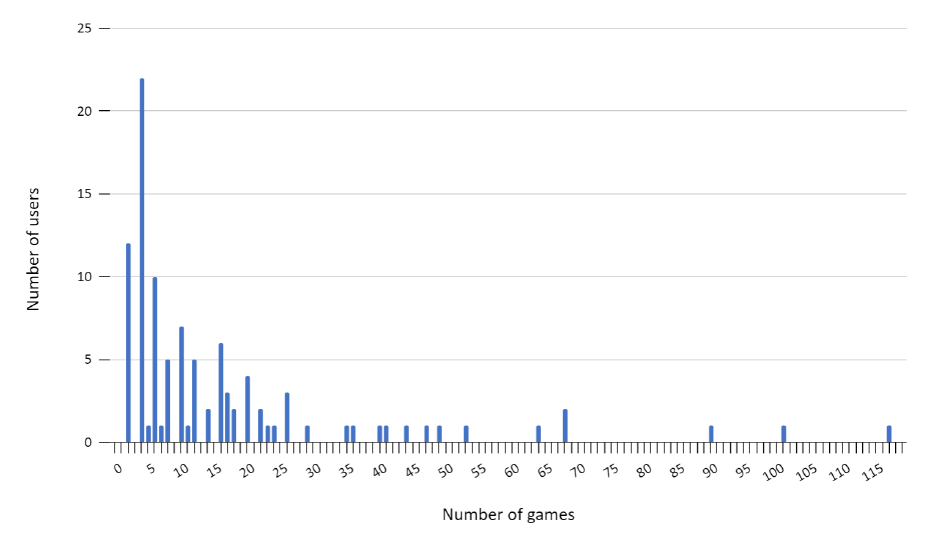
Figure 9. Number of users per number of games played during the entire